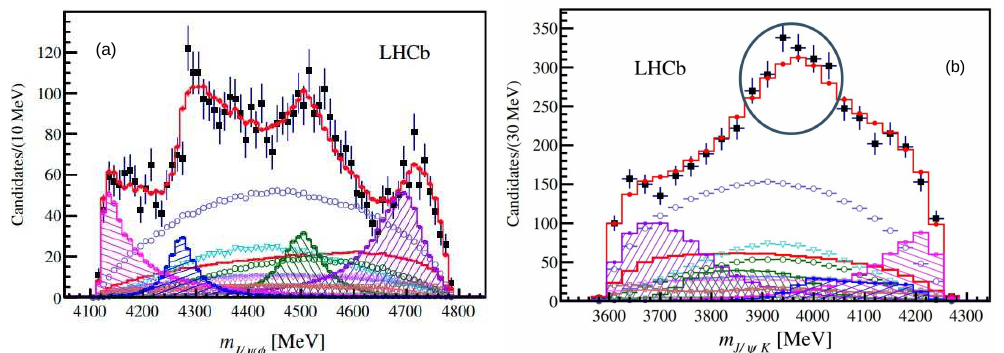
Figure 1: (a) The J /ψφ mass spectrum is shown. The multiple shaded histograms show the contributions from each of the X states, X(4140) , X(4274), X(4500) and X(4700) respectively. (b) The J /ψ K mass spectrum is shown. The circle highlights the area where there is a clear discrepancy between the data and the fit. This was measured to be 3 σ . In both plots the data are represented by the black boxes, with the fit is represented by the red line.